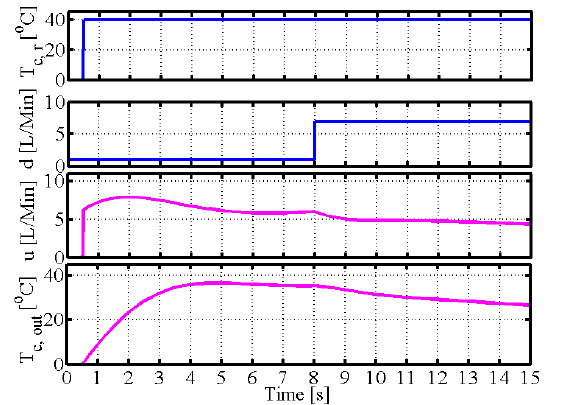
Figure 12. Simulation of operator control.